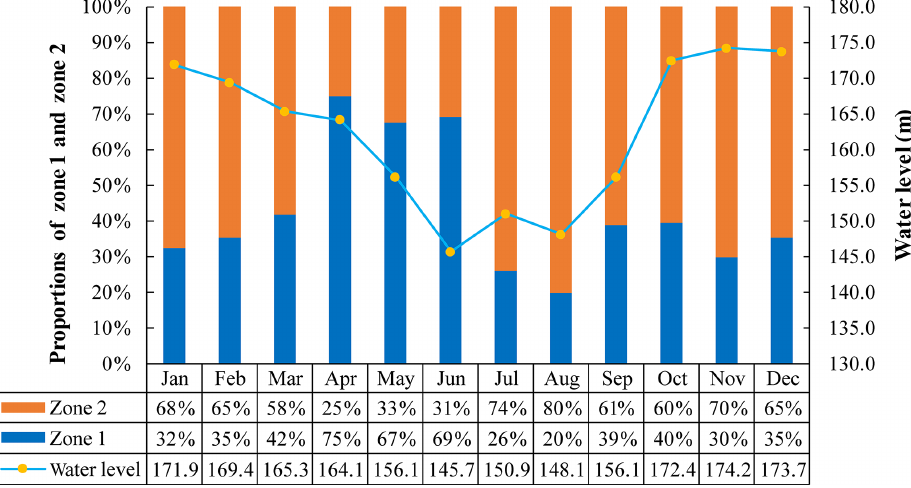
Figure 8. Proportions of zone 1 and zone 2 and the variation in water level. The orange bar represents zone 2, and the blue bar represents zone 1. The blue dashed line represents the variation in water level.